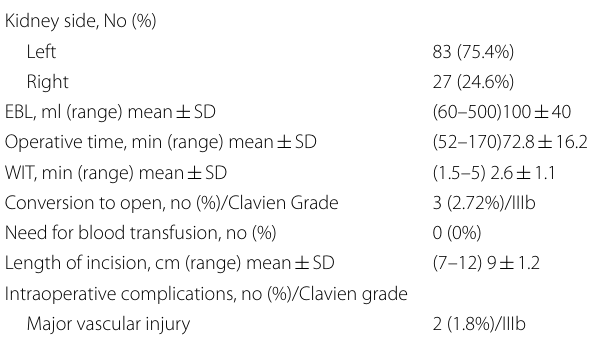
Table 2 Intraoperative data for the study population